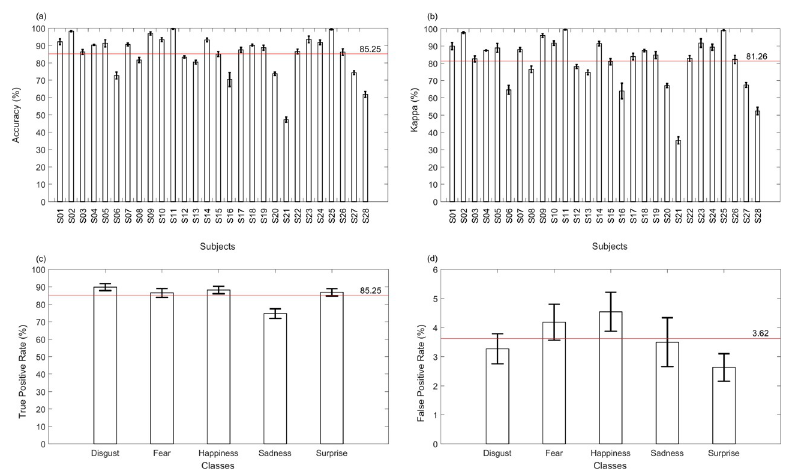
Fig 5. Performance of the emotion